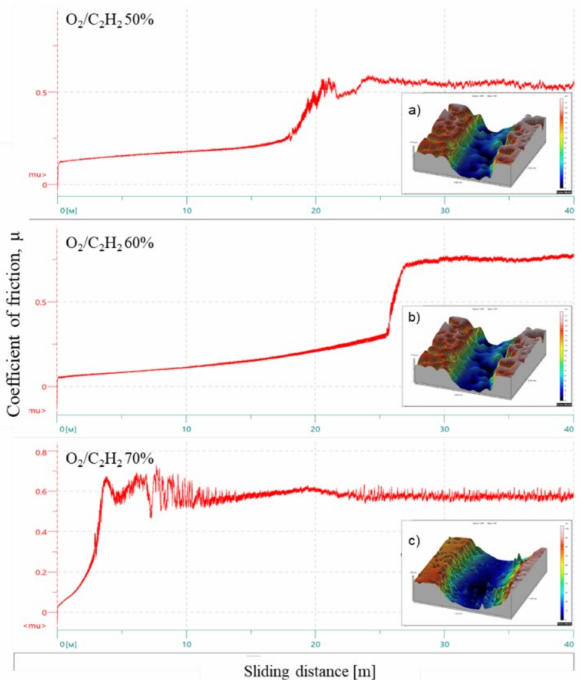
Figure 6. Tribological tests results of Ti–Si–C coatings obtained at different filling volumes of the explosive gas mixture of the detonation gun barrel and track profiles: ( a ) 50%; ( b ) 60%; ( c ) 70%